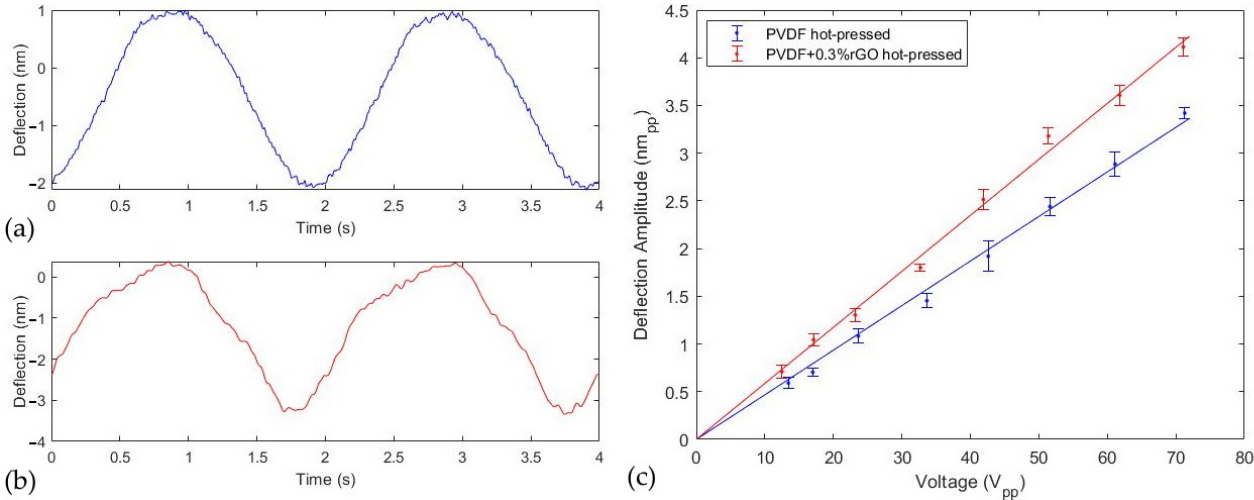
Figure 7. Deflection of AFM cantilever under 60 Vpp at 0.5 Hz for ( a ) PVDF; ( b ) PVDF + 0.3%w.t. rGO; ( c ) deflection amplitude of AFM cantilever for stimulation between 10 and 70